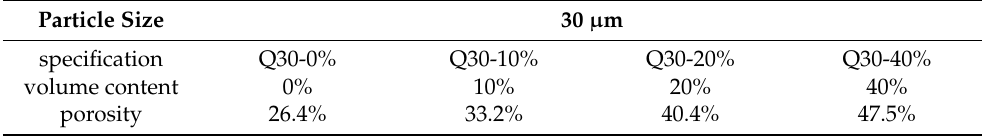
Table 2. Parameters of microchannels sintered with 10 μ m spherical copper powder.